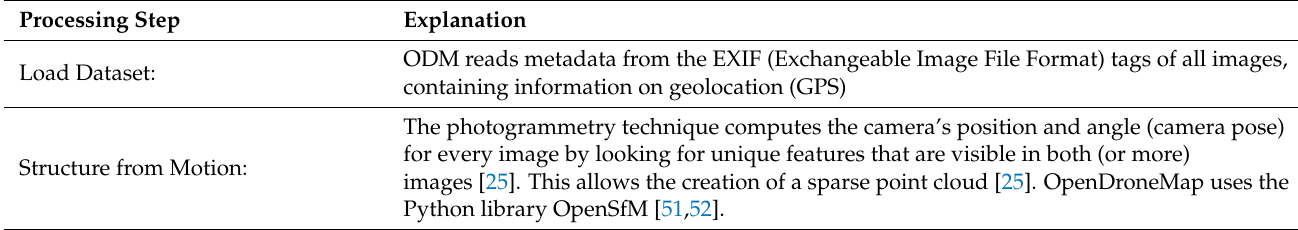
Table A1. Processing Pipeline of OpenDroneMap, modified after the official OpenDroneMap software guide [25]. Copyright © 2019 by Piero